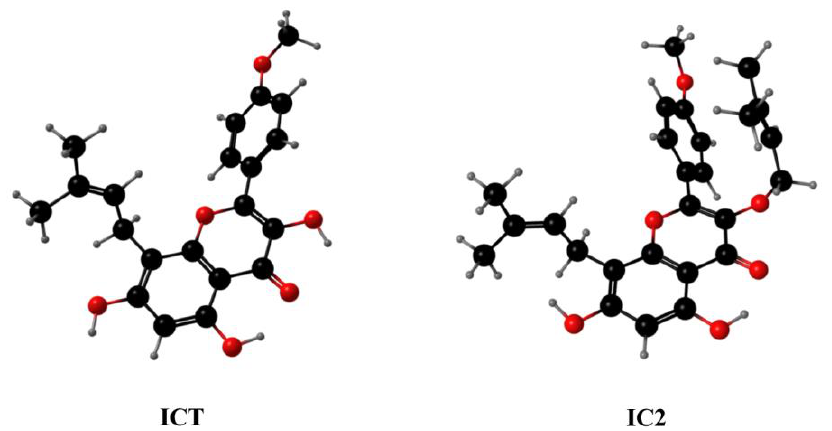
Figure 1. The three-dimensional chemical structures of ICT and IC2. Carbon is depicted with black balls. Oxygen is depicted with red balls. Hydrogen is depicted with gray balls.